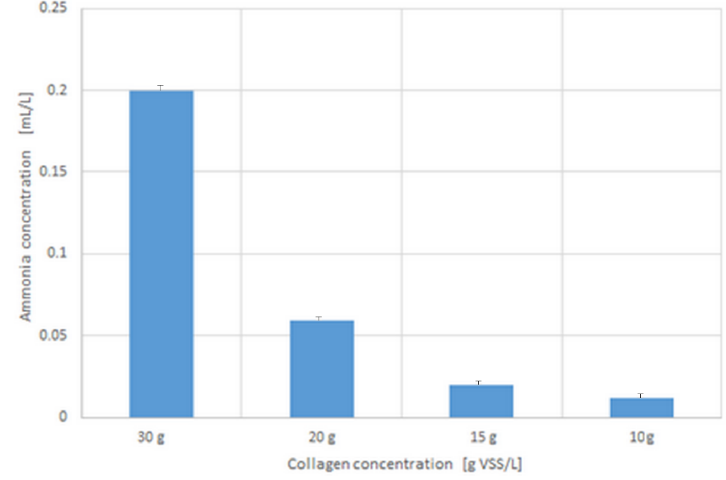
Figure 4. Ammonia concentrations change at dark fermentation of gelatine concentrations from 10 g VSS/L to 30 g VSS/L after 55 days. The pH growth depended on the gelatine concentration. Between the 19th to the 39th day of fermentation at 30 g VSS/L of gelatine, the pH value reduced and then returned to the earlier point. During this period, the pH was decreased by low volatile acids (see Fig- ure 5).